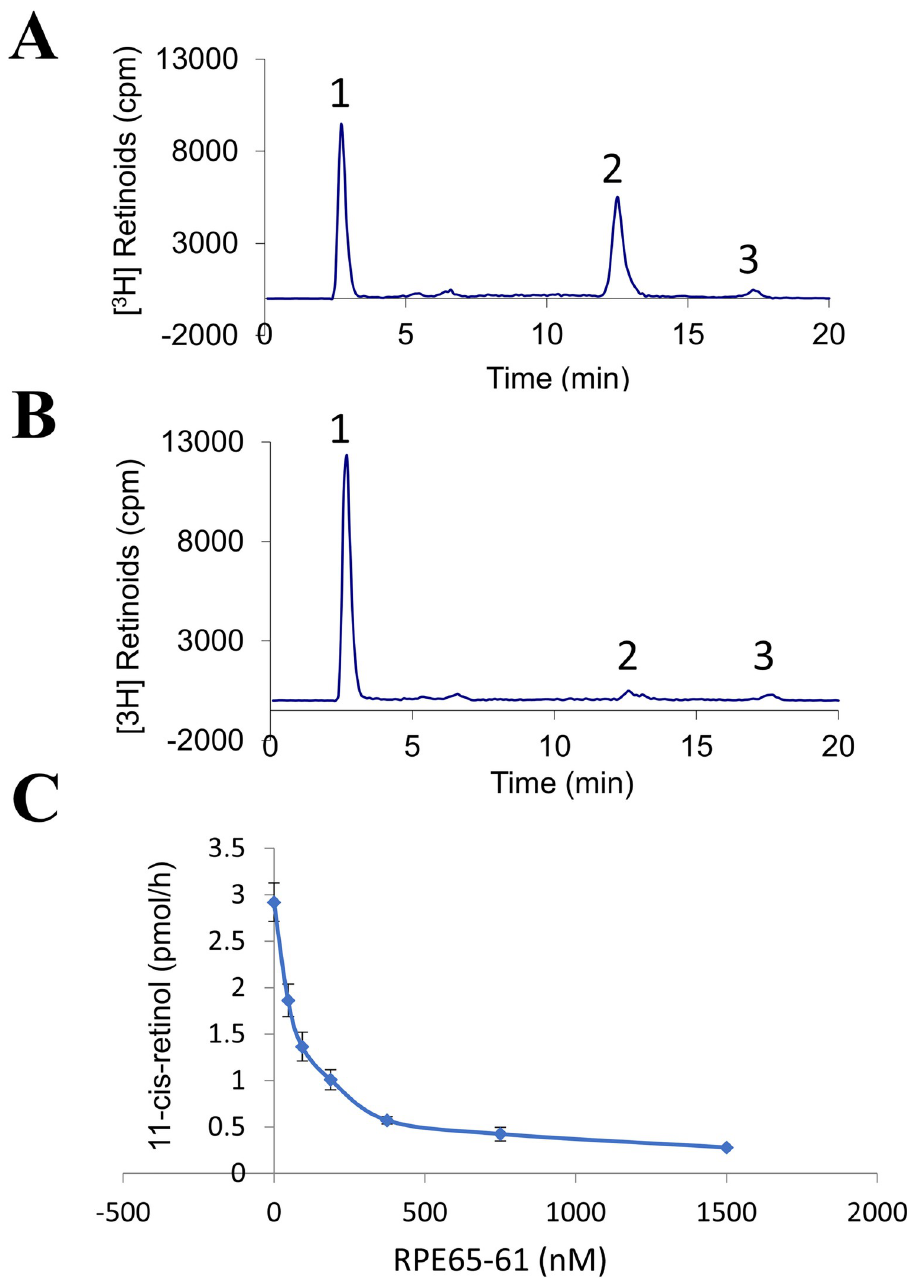
Fig 2. ( ± )-RPE65-61 inhibits retinol isomerase activity in vitro. Bovine RPE microsomes (25 μ g) were incubated with 0.2 μ M of all- trans - [ 3 H]-retinol in the presence or absence of ( ± )- RPE65-61 for 1h at 37˚C. The generated retinoids were analyzed by HPLC coupled with flow scintillation analyzer. (A) HPLC elution profile without inhibitor; (B) with 375 nM of RPE65-61. Peak 1, retinyl esters; 2, 11- cis -retinol; 3 all- trans -retinol. (C) ( ± )- RPE65-61 concentration-dependent inhibition of 11- cis -[ 3 H]-retinol generation (mean ± SEM, n = 3). production (peak 2) (Fig 2B). ( ± )- RPE65-61 did not suppress the production of retinyl ester (peak 1), implying that LRAT was not inhibited. ( ± )- RPE65-61 also reduced isomerase activity with an apparent IC of 80 nM in a concentration-dependent manner (Fig 2C). Despite 50